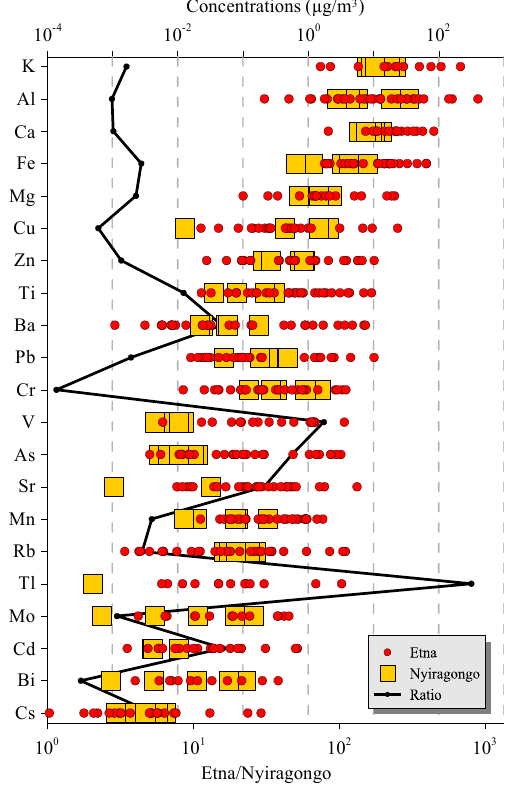
Figure 2: Metal/S ratios in the plumes of the two volca- noes. Elements are ordered basing on decreasing median values of